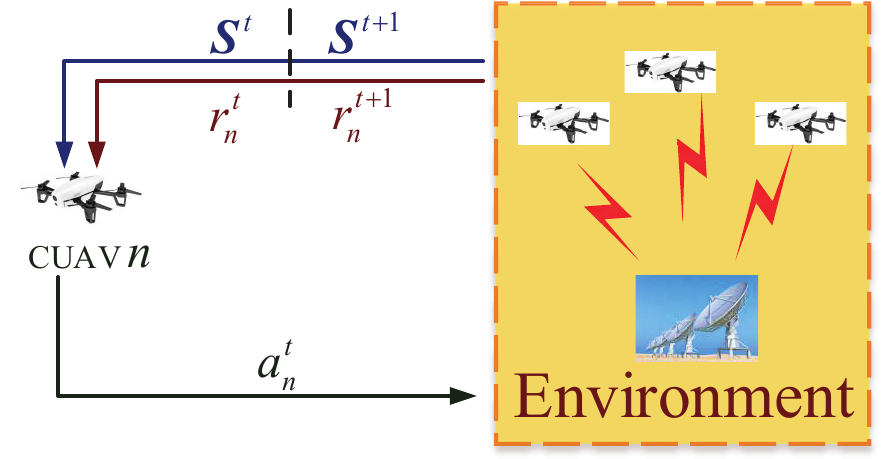
Figure 4. IL-Q-UCB-H of CUAV n for joint sensing and